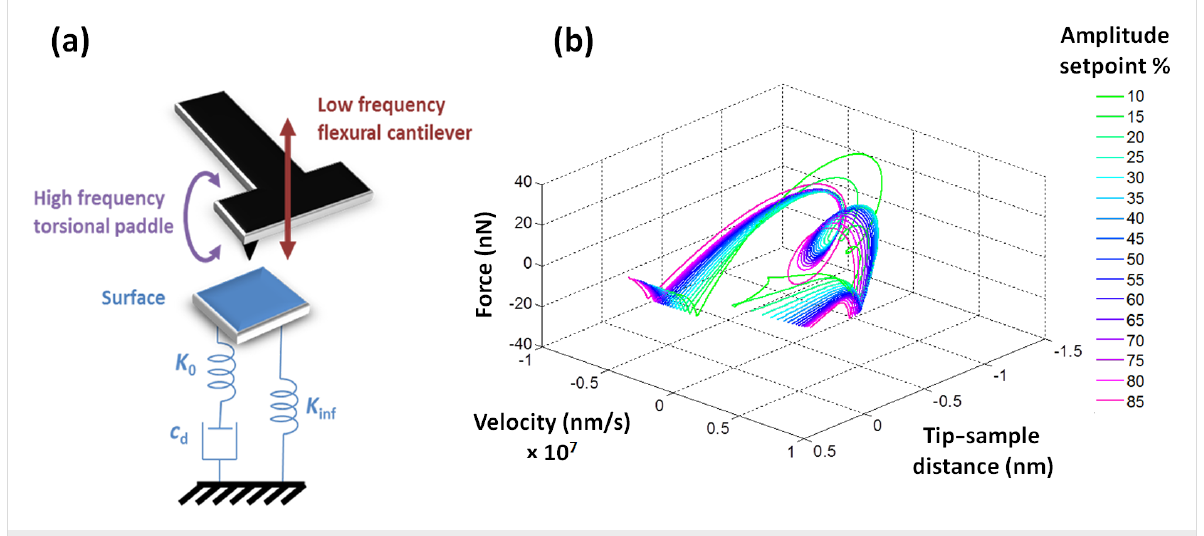
Figure 3: (a) Schematic of a torsional harmonic cantilever interacting with a surface modeled as a standard linear solid ( K o and K inf represent linear springs and c d represents a linear damper); (b) collection of force curves acquired for different values of the amplitude setpoint by using the same cantilever. Note that the force curves in (b) exhibit a loop, indicating that the tip travels into and towards the surface twice during each flexural cycle resulting in a “double tap”. This can occur whenever two eigenmodes with different natural frequencies are active. Similar phenomena take place when imaging samples in high-damping (liquid) environments [18] or in multifrequency AFM characterization [19].